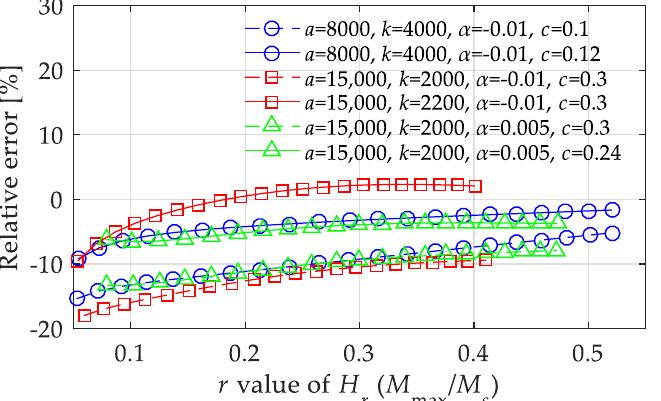
Figure 12. Relative errors of the 1st LTI system model in calculating the magnetization amplitude under boundary conditions with highest errors.